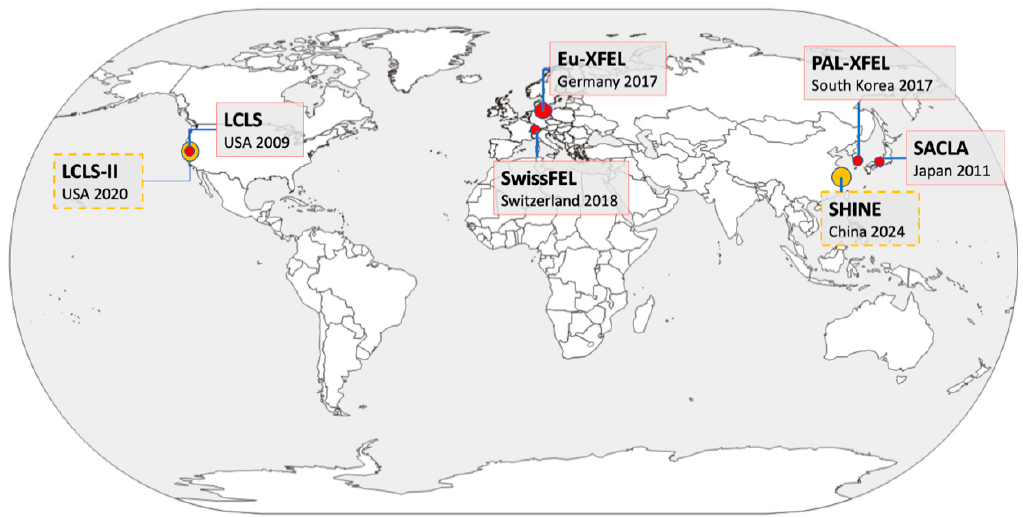
Figure 1. A map of X-ray free electron laser (XFEL) facilities. Five of these are in operation (red circles), and two facilities (Linac Coherent Light Source (LCLS)-II and Shanghai HIgh repetition rate XFEL aNd Extreme light facility (SHINE), orange circles) are designed to operate at 1 MHz in continuous wave (CW) mode, in contrast to the long pulse (LP) mode in Eu-XFEL.